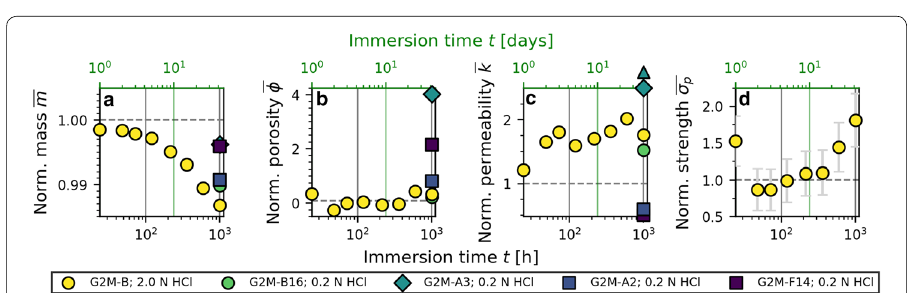
Fig. 6 Normalised physical property data for samples subject to acid immersion. Symbols and colours distinguish different starting materials and acid molarities. Dashed horizontal line indicates no change. a Change in mass over time. b Change in porosity. c Change in permeability. d Change in strength relative to untreated samples (Table